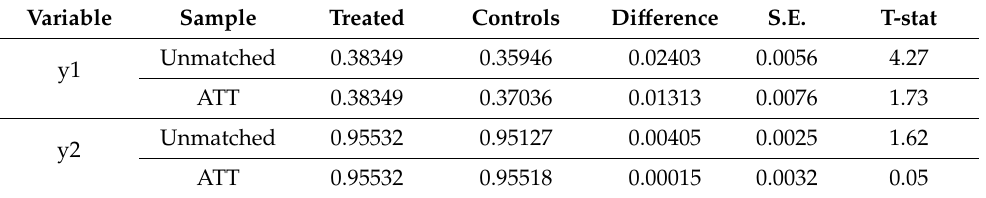
Table 4. Average treatment e ff ect on the treated (ATT) estimated by the Mars matching method. Variable Sample